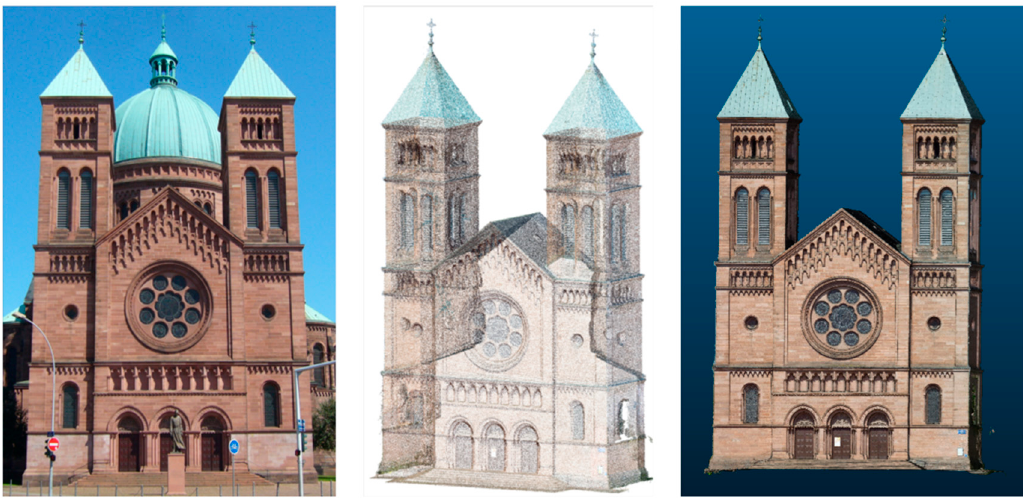
Figure 2. The main façade (left), cleaned point clouds (middle), and mesh geometry (right) of the St-Pierre-le-Jeune Church in Strasbourg, France, built from typical Alsatian red sandstone.